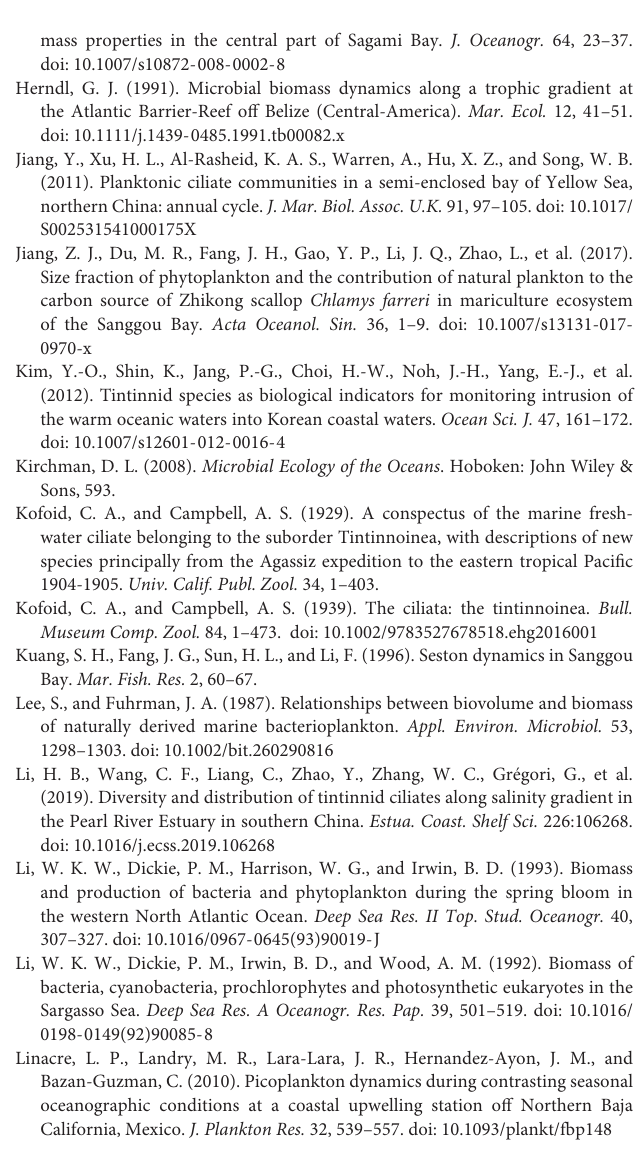
Supplementary Figure 1 | Cluster analysis of stations according to temperature and salinity in four successive seasons, spring to winter. Supplementary Figure 2 | Cluster analysis of stations according to microbial food web component biomasses in four successive seasons, spring to winter. Supplementary Figure 3 | Cluster analysis of stations according to tintinnid abundance in four successive seasons, spring to